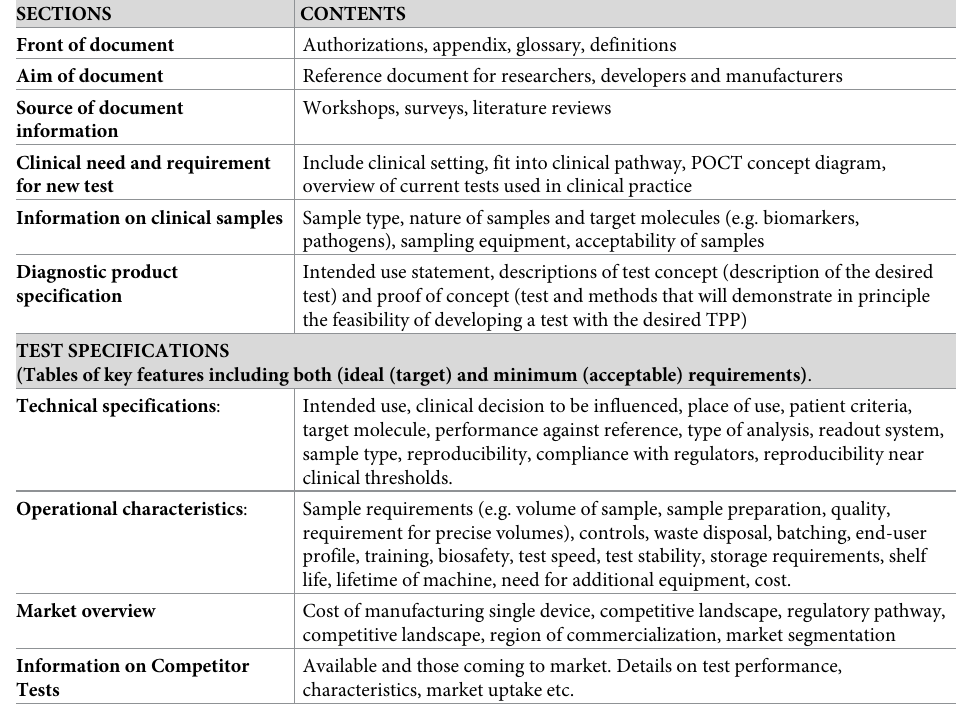
Table 2. Structure of the target product profile (TPP)